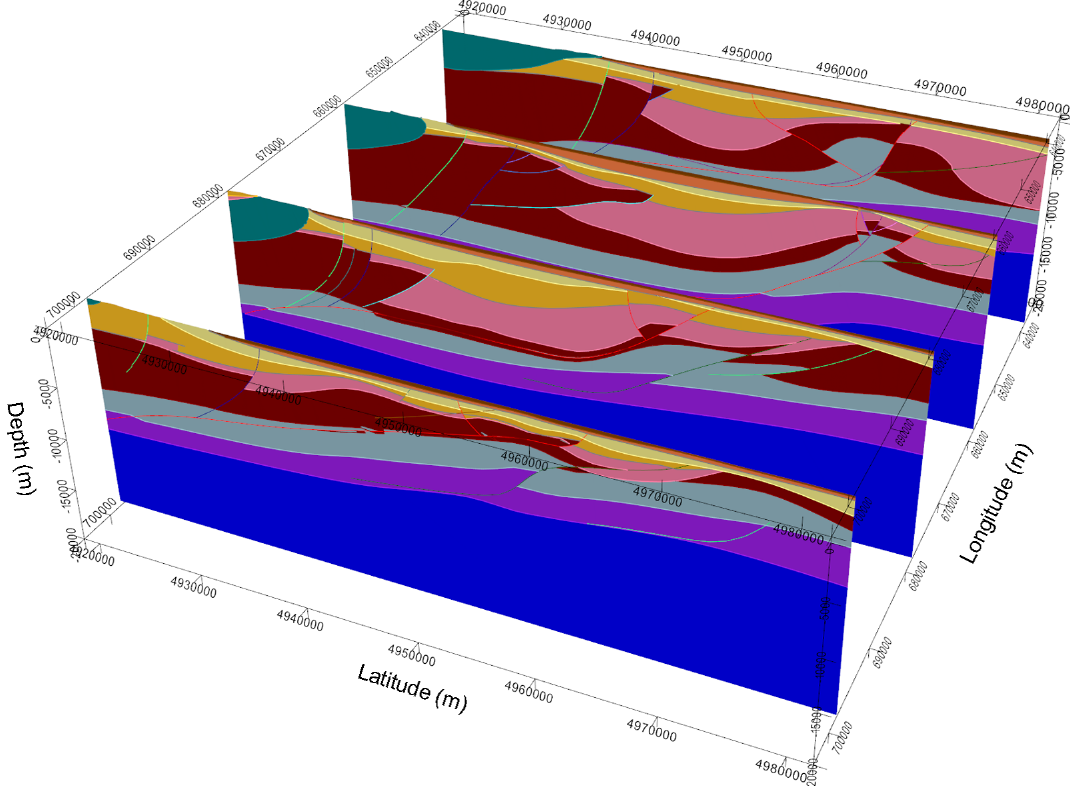
Figure 5. 3-D model: four equally spaced north–south 2-D vertical sections across the investigated volume. Stratigraphic pile as in Fig. 4c.